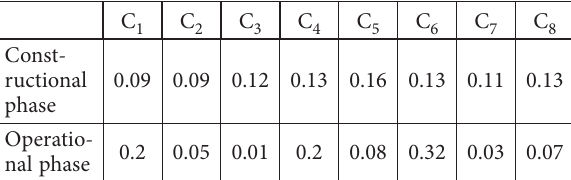
Table 5. The final criteria weights in two different phases